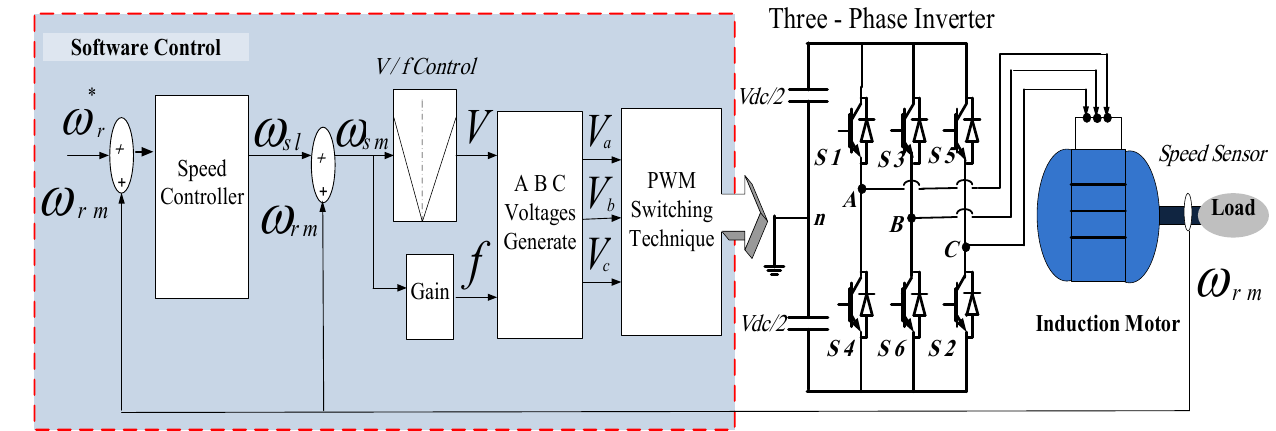
Figure 3. Scalar closed-loop control for IM drive.